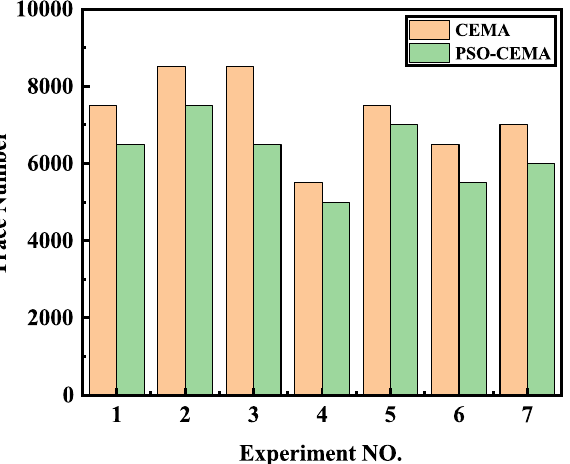
Figure 11. The minimum number of electromagnetic traces when the right key is recovered.